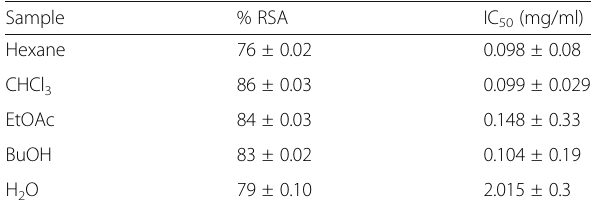
Table 3 Antioxidant activity (%RSA and IC 50 ) of solvent fractions of S.